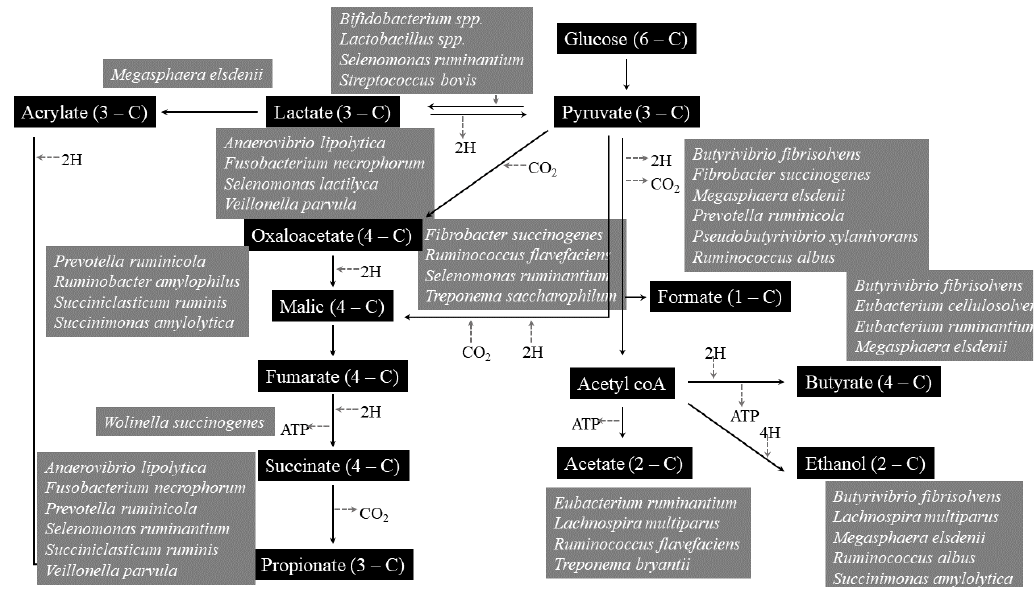
Figure 5. Main microbes involved in rumen fermentation processes .